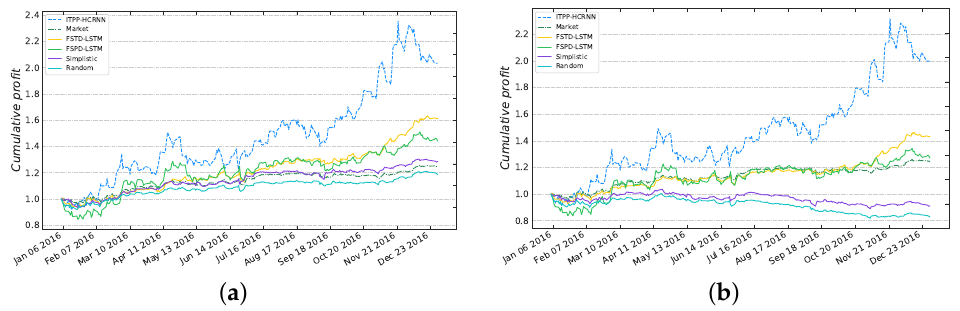
Figure 8. Impact of transaction costs. Transaction costs are not considered in ( a ). Transaction costs are considered in ( b